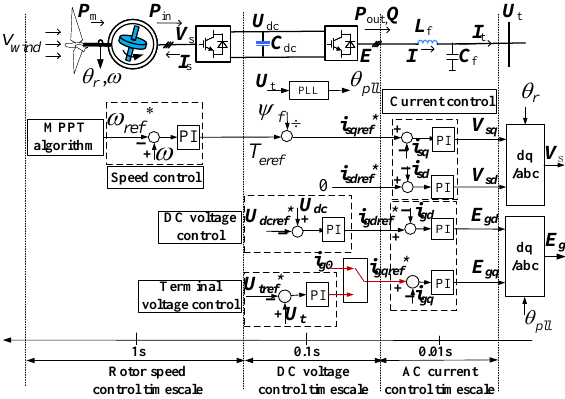
Figure 1. A widely used control scheme of PMSG-based WTs.